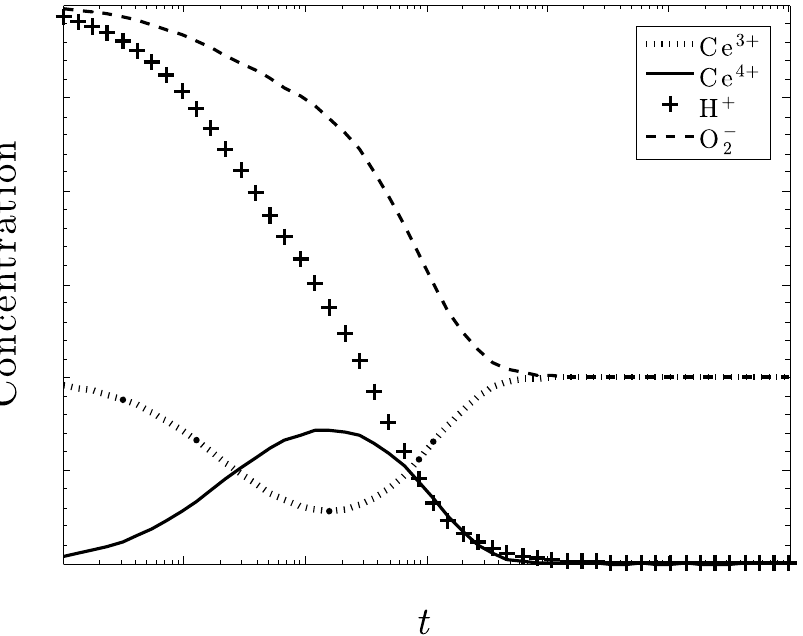
Figure 7. An initial concentration of superoxide three times the concentration of ceria, all in the +3 state. The concentration of superoxide ions is not well controlled.